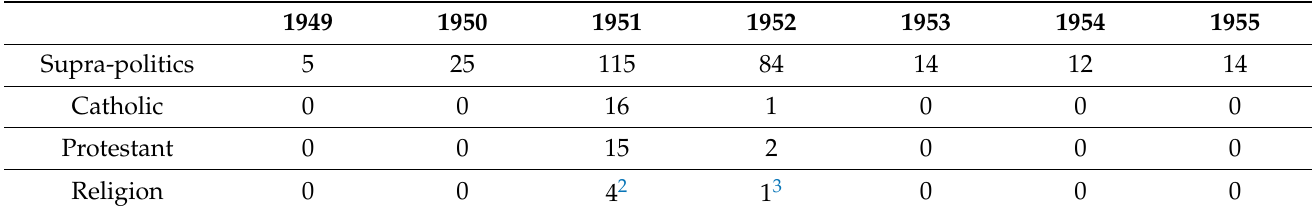
Table 1. Statistics of articles in GMD carrying criticisms of “supra-politics”